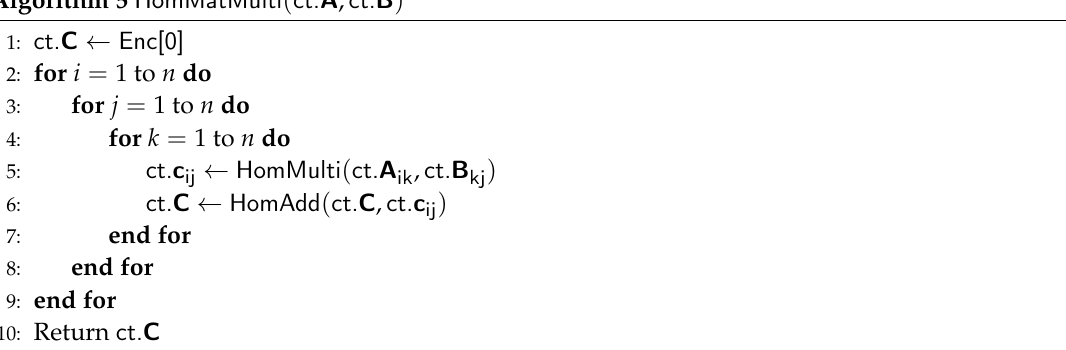
Algorithm 5 HomMatMulti ( ct. A , ct. B